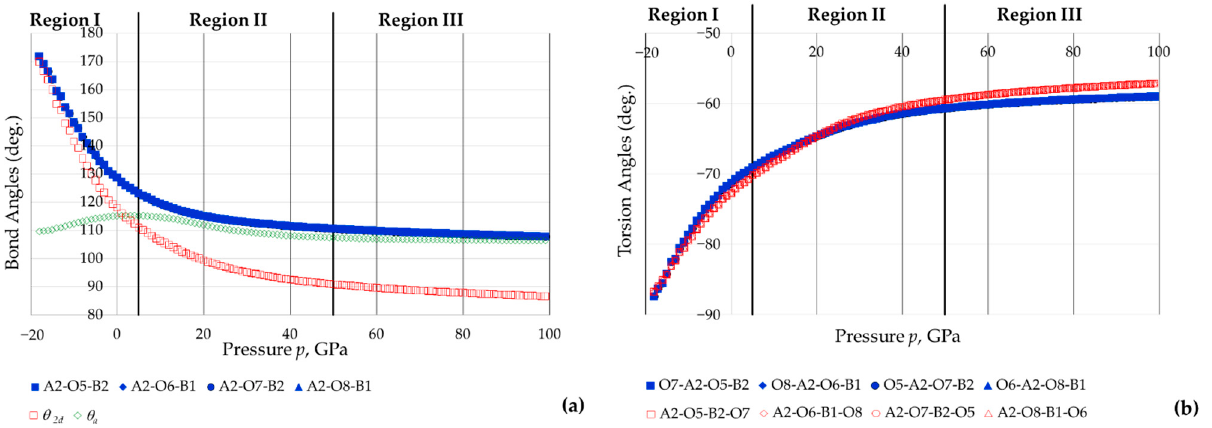
Figure 10. ( a ) The variation with pressure p of the inter-tetrahedral B-O-As angles (collectively known as θ 3 d and their 2D projection ( θ 3 d ) compared to a typical intra-tetrahedral bond-angle change; ( b ) the variation with pressure p of the torsion